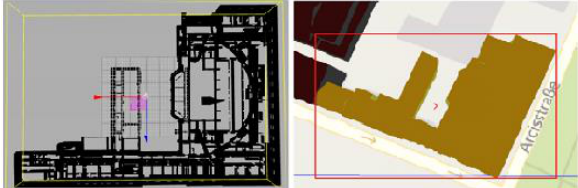
Figure 12: Comparison of the origin of coordinates of a glTF model created by BIMserver (a) and the calculated bounding box centre of the corresponding CityGML buildings within the 3D map client